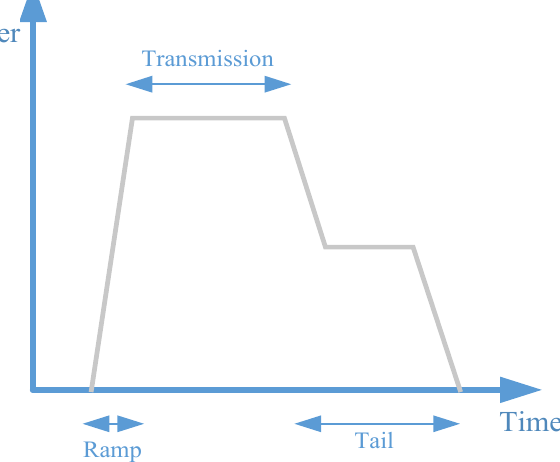
Figure 5. Common three stages of a 3G transmission: the ramp and the tail are transitions to and from high-power states where the actual transmission takes place. Based on